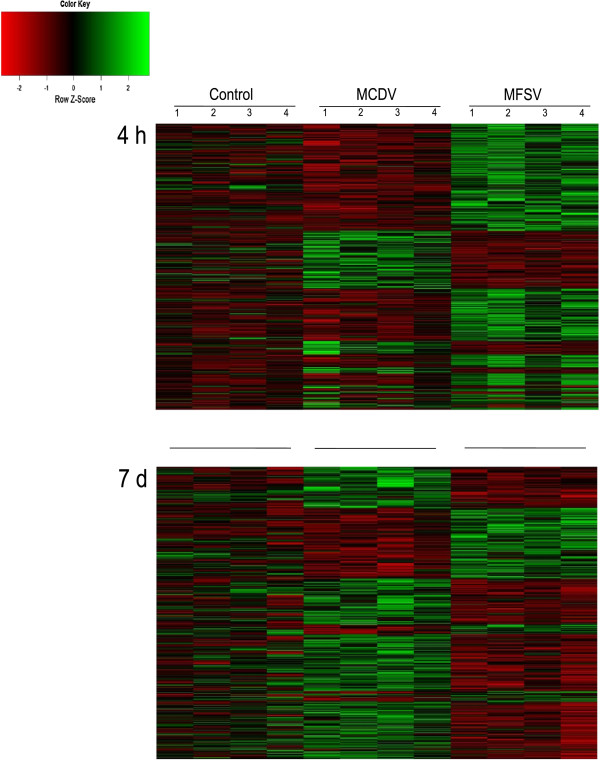
Transcriptional profiles of the 1,046 and 536 G. nigrifrons transcripts with a significant treatment effect at 4 h and 7 d, respectively. Both analyses are based on one-way ANOVA with P-level significance at 0.05 and RPKM change >2. Each row represents an individual transcript; each column labeled 1–4 represents a replicate sample that was fed on healthy (control) or virus-infected (MCDV or MFSV) maize. For each transcript (row), the relative expression level in each sample (column) is represented by a color that reflects its row z-score (shown in the grayscale key), calculated by subtracting the mean expression value for the row from individual sample values and dividing by the standard deviation of the row.